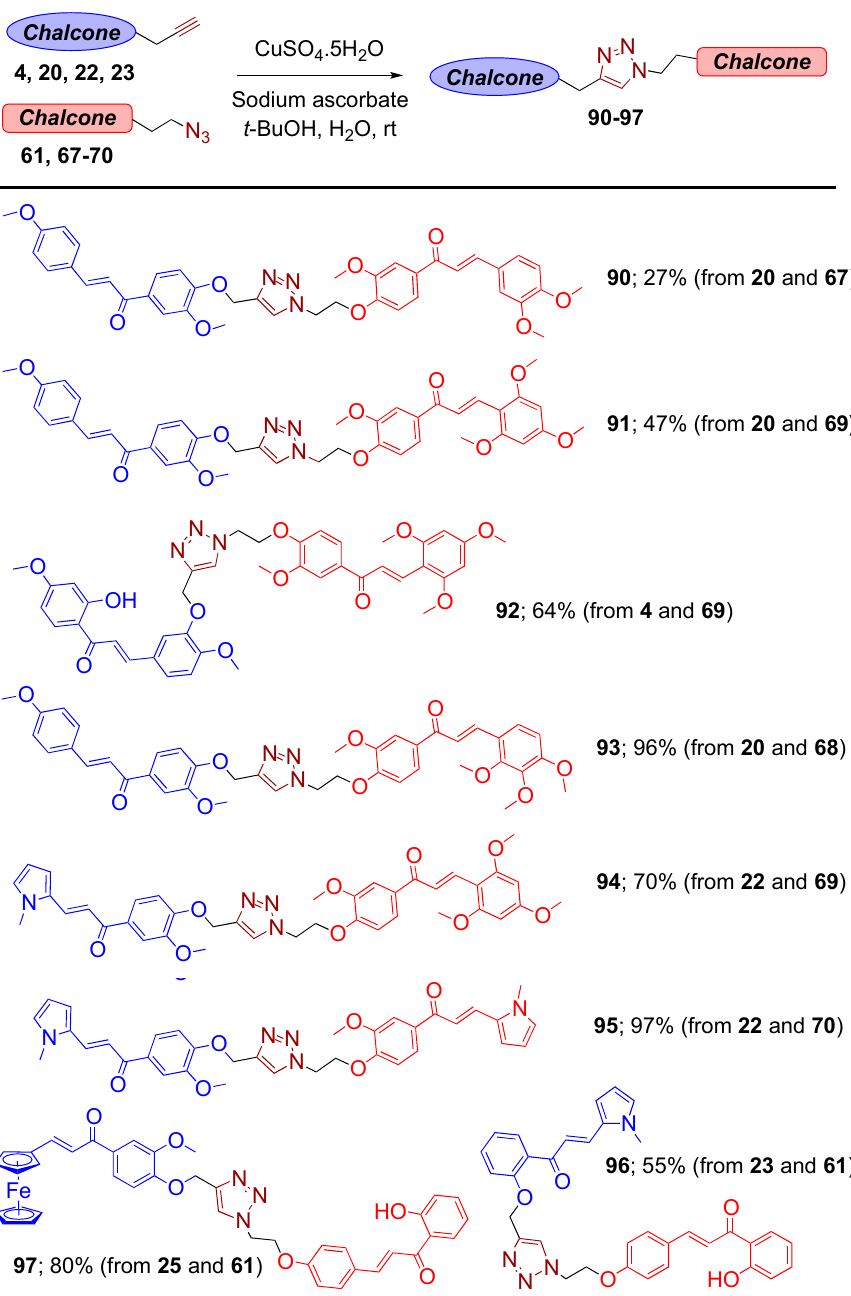
Scheme 17. Synthesis of triazole-bridged flavone-chalcone dimers.